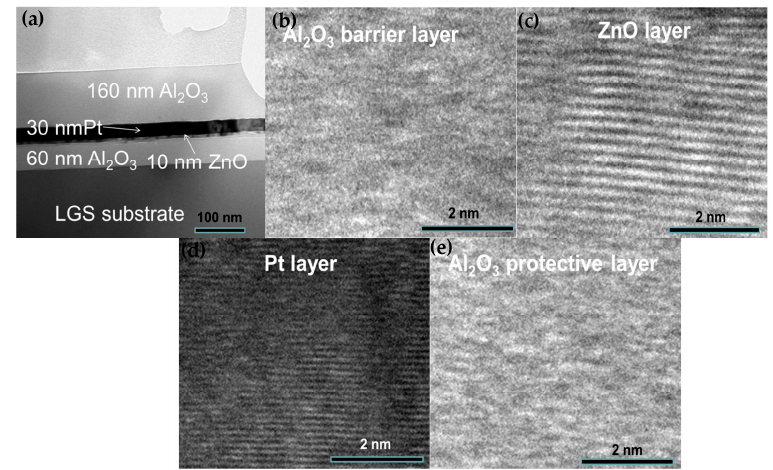
Figure 3. ( a ) The cross-sectional TEM (transmission electron microscope) image of Al 2 O 3 /Pt/ZnO/Al 2 O 3 /LGS sample. The enlarged HR-TEM (high resolution- transmission electron microscope) images from the regions of ( b ) Al 2 O 3 barrier layer; ( c ) ZnO buffer layer; ( d ) Pt film; and ( e ) Al 2 O 3 protective layer.